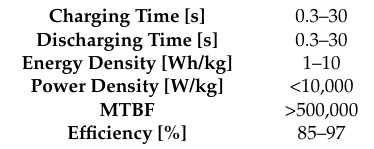
Table 7. Ultracapacitor